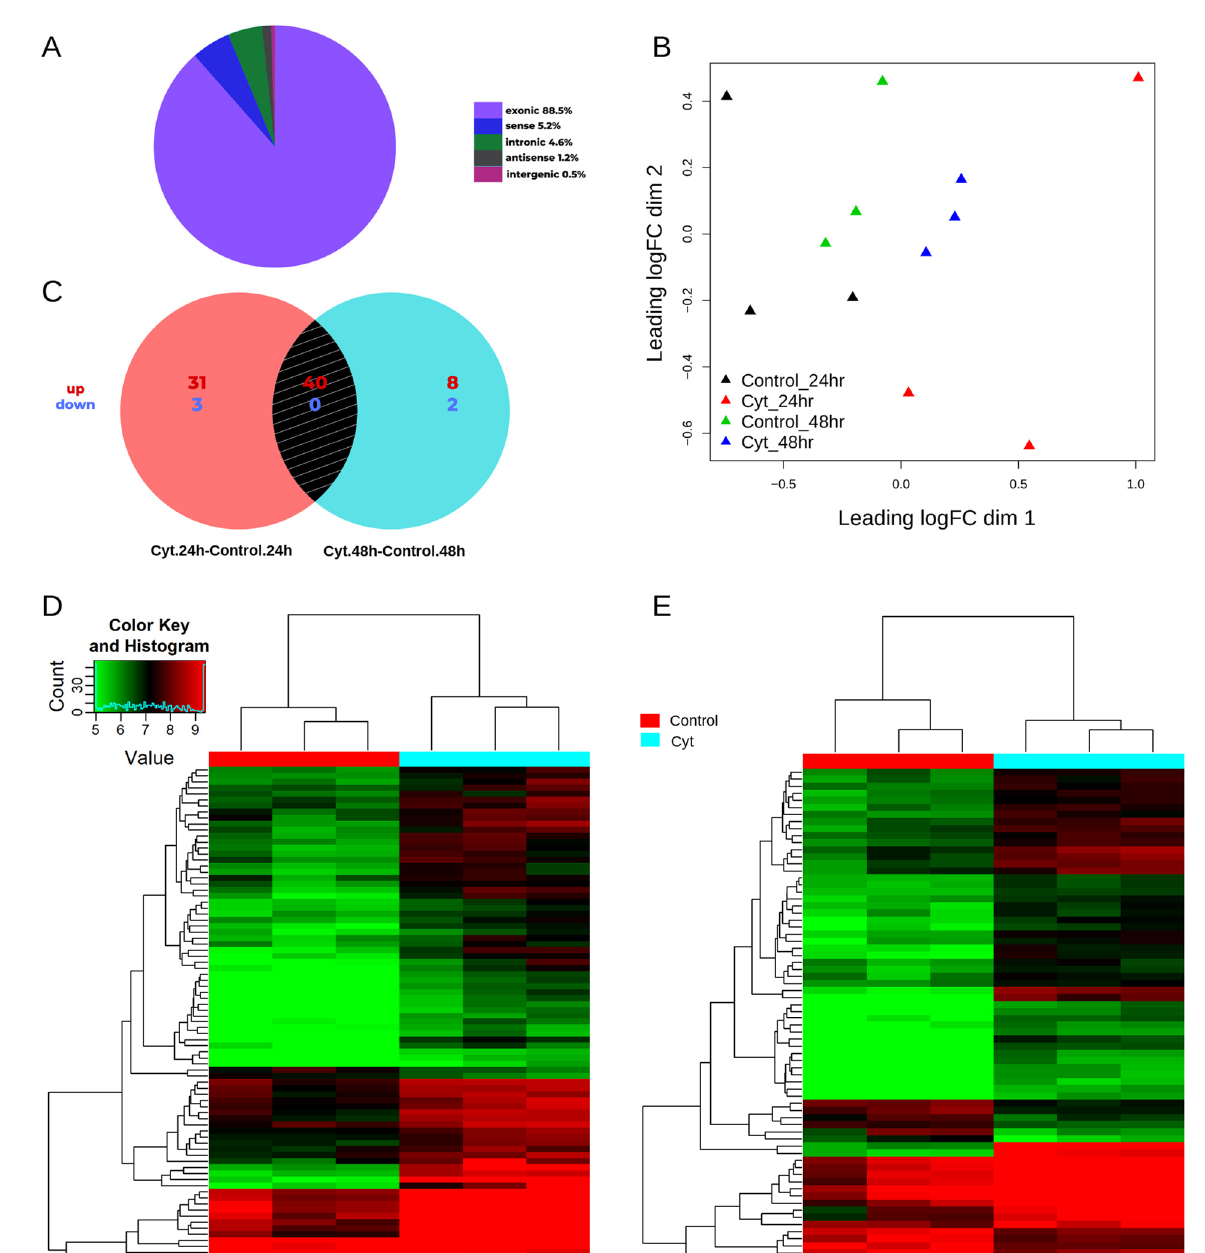
Figure 1. CircRNAs modulated by pro-inflammatory cytokines in human β cells. ( A ) Distribution of circRNAs expressed in human EndoC- β H1 cells based on their biotypes; ( B ) MDS plot showing the effect of cytokine-treatment at different time-points in EndoC- β H1 samples; ( C ) Venn diagram showing the overlap between the number of DE circRNAs after cytokine exposure at 24 h and 48 h; ( D , E ) Hierarchical clustering of DE circRNAs based on their normalized expression values at 24 h ( D ) and 48 h ( E ) after cytokine